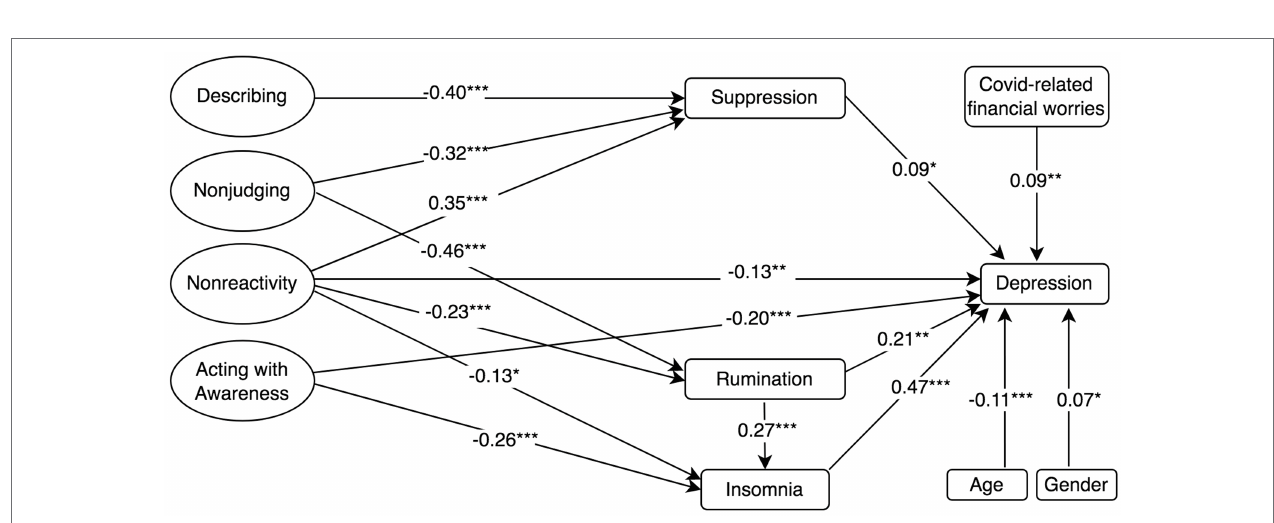
FIGURE 4 | Standardised mediation Model 4 of the effect of the five facets of mindfulness on depression. Depression = PHQ-8, 8-item Patient Health Questionnaire; Rumination = RSS-SF, 10-item Rumination Response Scale-Short Form; Cognitive Reappraisal and Suppression = ERQ, 10-item Emotion Regulation Questionnaire; Insomnia = ISI, 7-item Insomnia Severity Index; and Mindfulness and facets = FFMQ-SF, 24-item Five-Facets Mindfulness Questionnaire-Short Form. † p < 0.10; * p < 0.05; ** p < 0.01; and *** p ≤